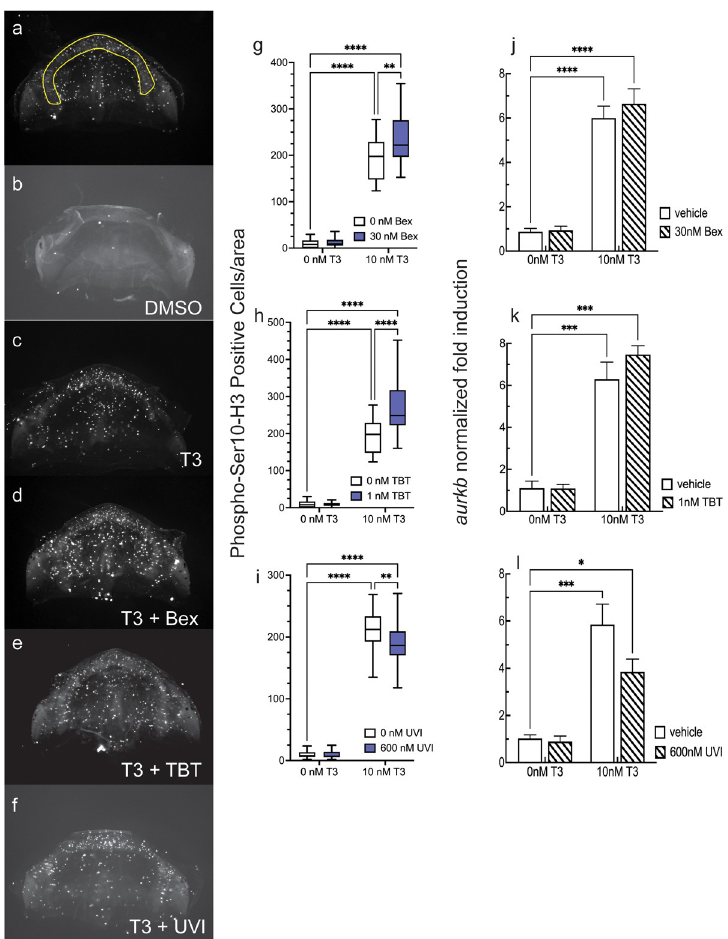
Fig 3. RXR agonists potentiate T3 action on cellular proliferation in the LJ of 1wk-PF tadpoles. a: MC-IR region used for quantitation of proliferation. b-f: Representative photos of the effects of different treatments on proliferation using phopho-Ser10-H3 reactivity. g-i: Quantification of proliferation in the presence and absence of T3 and RXR ligands normalized to the area counted. Boxes and statistics are as in Fig 1 (n = 20–30 jaws from 2–3 clutches). j-l: RXR ligands do not significantly affect the T3-induced expression of aurora kinase B mRNA ( aurkb ). Bars represent the mean of 3–6 independent clutches, and statistics show results from Sidak’s multiple comparison test in conjunction with 2-way ANOVA ( ���� , p < 0.0001; ��� , p < 0.001; �� , p < 0.01; � , p < 0.05). representative photos of different ligand treatment combinations from which proliferative cells were counted and normalized to the area counted. For quantification, each combination of T3 and RXR ligand were assayed with two independent clutches, and for each clutch, RXR ligand effects were significant. Fig 3G–3I shows the two clutches combined for each group. Vehicle- treated LJs had few proliferative cells (Fig 3G–3I). In contrast, treatment with 10 nM T3 increased the number of mitotic cells at least 15-fold for each treatment group. Co-treatment of either 30 nM Bex (Fig 3G) or 1 nM TBT (Fig 3H) RXR agonists with T3 resulted in a significant increase in the number of proliferating cells in the MC-IR cartilage. Since the RXR agonists induced a signifi- cant increase in proliferative cells, we expected that co-treatment of the RXR antagonist UVI with T3 would result in a decrease in proliferative cells. Fig 3I shows that UVI significantly inhibited cellular proliferation in the MC-IR. Aurora kinase B ( aurkb ) is the kinase that performs the phos- phorylation of Ser10 of H3. T3 induced aurkb mRNA expression (Fig 3J–3L). However, neither